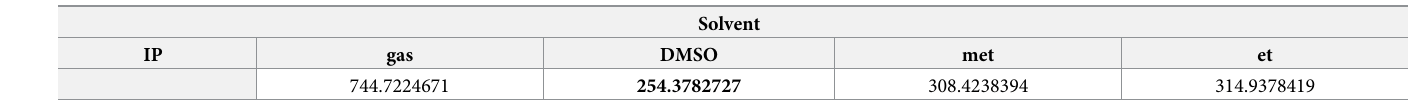
Table 4. IP values in kj/mol obtained at DFT/M06-2X/6-311++Gdp level of